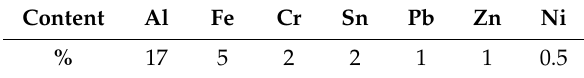
Table 8. Averaged content of various elements in samples M and S measured by MLA.